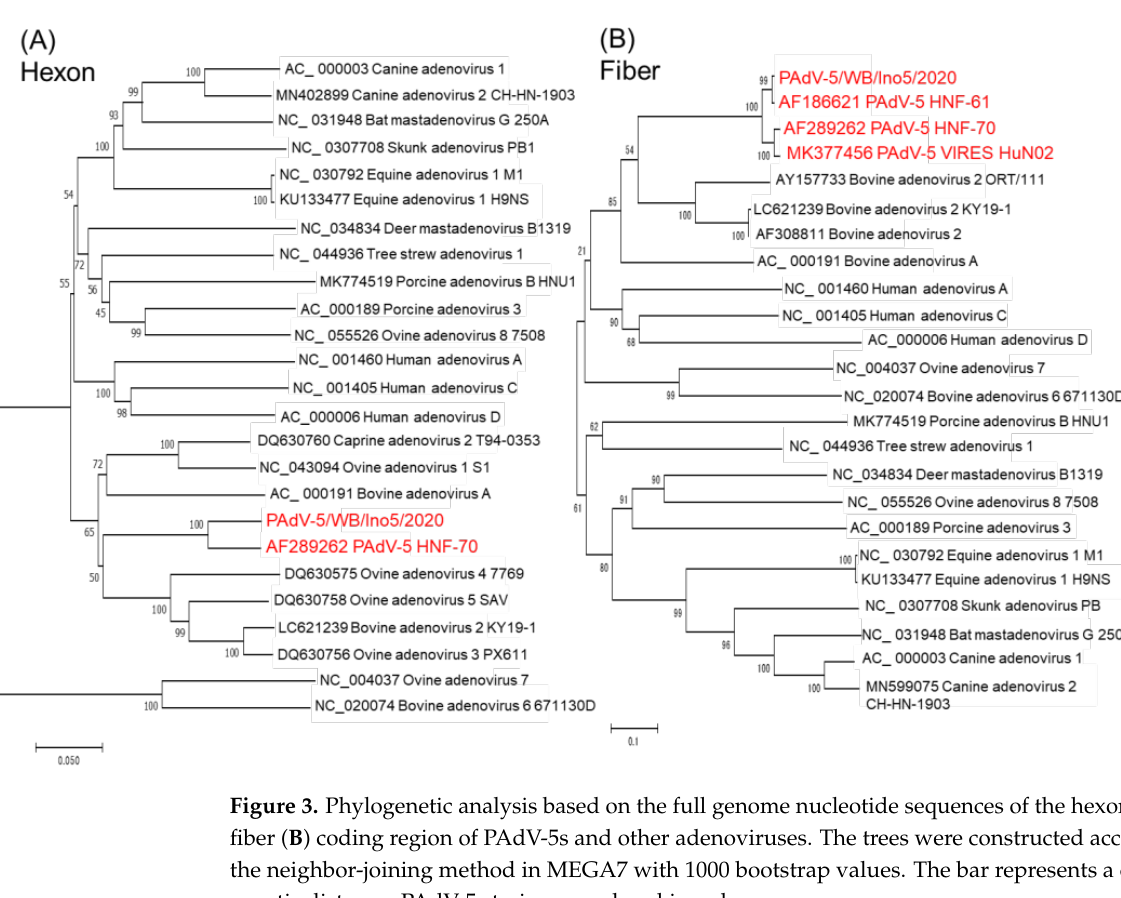
5 of 12 (green curve), bovine adenovirus 2 KY-19-1 (orange curve), partial genome of PAdV-5 HNF-61 (red curve), PAdV-5 HuN02 (blue curves), PAdV-5 YN01 (light blue curves), YN02 (grey curves), and PAdV-5 Ino5 as query sequence, with a sliding window of 200 nt and a moving step size of 20 nt ( B ) Recombination analysis of PAdV-5 HNF-70 vs. bovine adenovirus 2 KY19-1 (yellow curve), PAdV- 5 HNF-70 vs. PAdV-5 Ino5 (green curve), and bovine adenovirus 2 KY19-1 vs. PAdV-5 Ino5 (purple curve) ( C ) Average GC% content per gene across PAdV-5 Ino5 genome ( D ). Since sequence differences of the hexon and fiber protein between Ino5 and HNF-70 were observed (Figure 2B), phylogenetic analyses using the full genome sequences of the